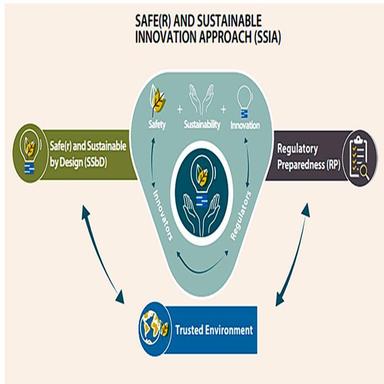
Schematic representation of the Safe(r) and Sustainable Innovation Approach (SSIA). Source: